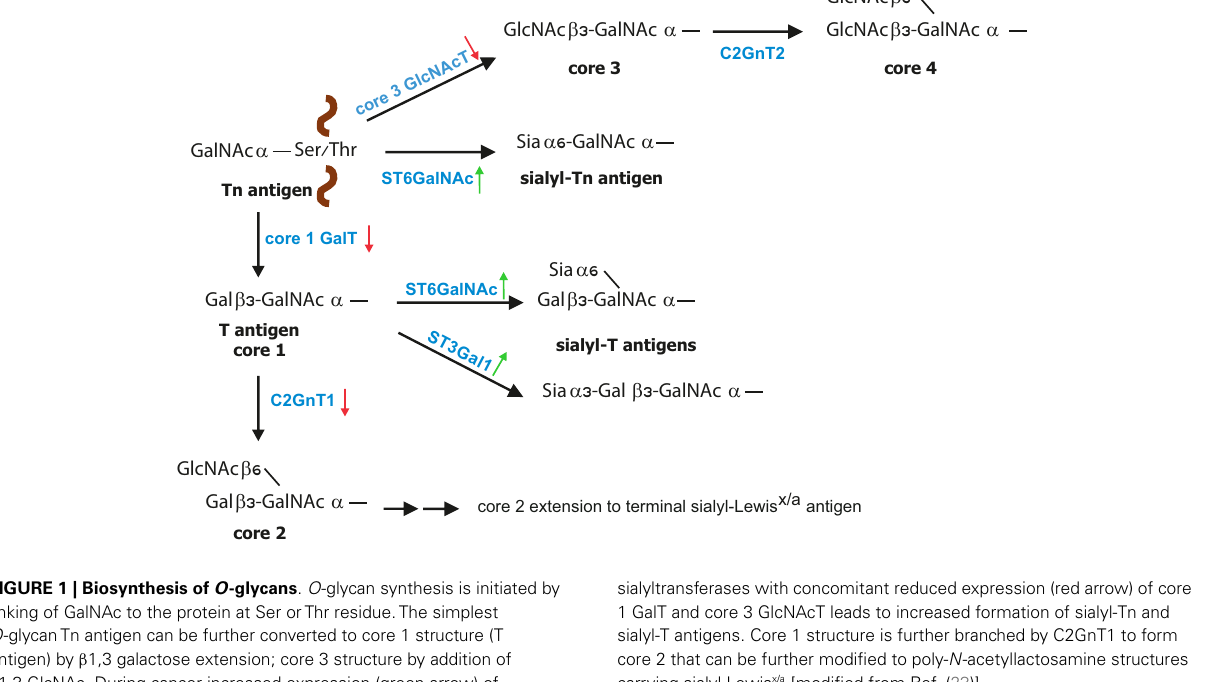
sialyltransferases with concomitant reduced expression (red arrow) of core 1 GalT and core 3 GlcNAcT leads to increased formation of sialyl-Tn and sialyl-T antigens. Core 1 structure is further branched by C2GnT1 to form core 2 that can be further modified to poly- N -acetyllactosamine structures carrying sialyl-Lewis x/a [modified from Ref.